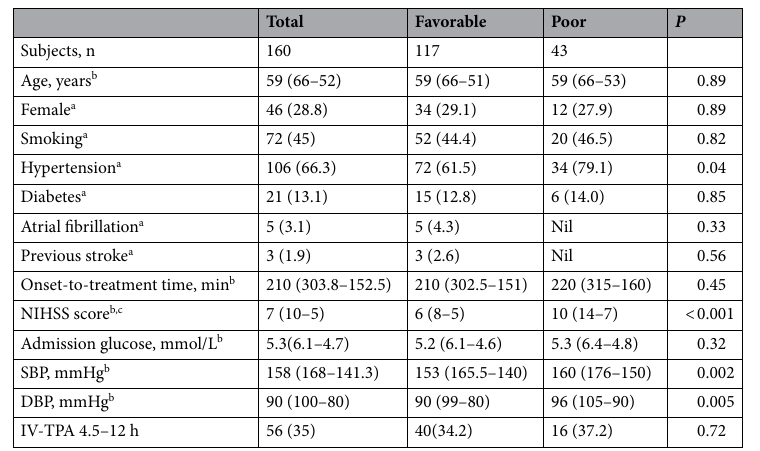
Table 1. Baseline and clinical characteristics of patients with LSA stroke by outcomes. a n (%). b Median (IQR = Q3–Q1). c